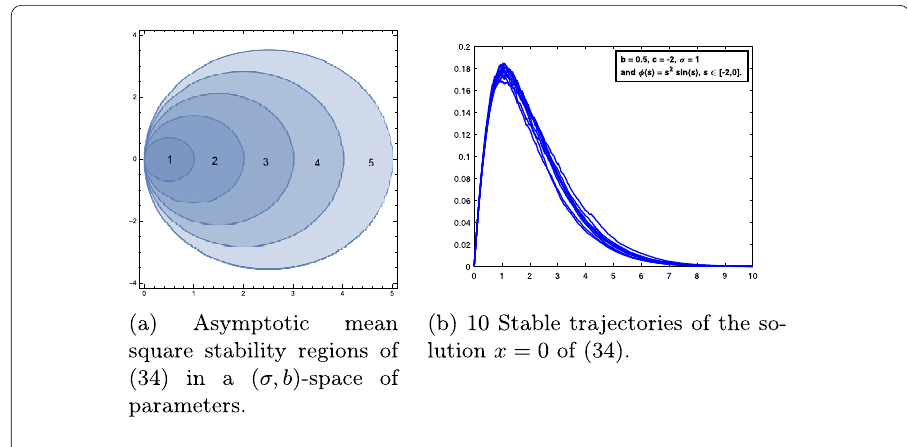
Figure 1 ( a ) Stability regions. ( b ) Trajectories of the